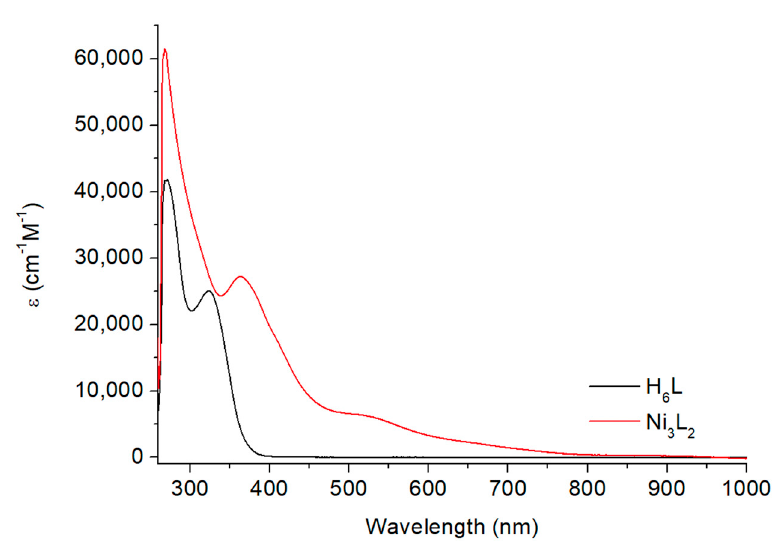
Figure 4. Electronic absorption spectra for the H 6 L ligand and the Ni 3 L 2 complex, concentration of 0.05 mM in DMF.